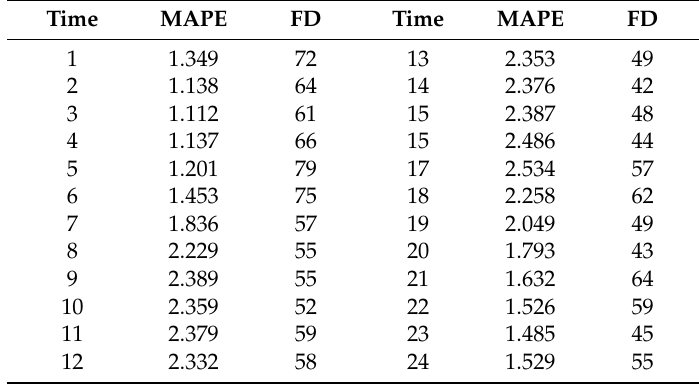
Table 9. Optimal feature subset construction of different hours with MI + RF for Singapore.